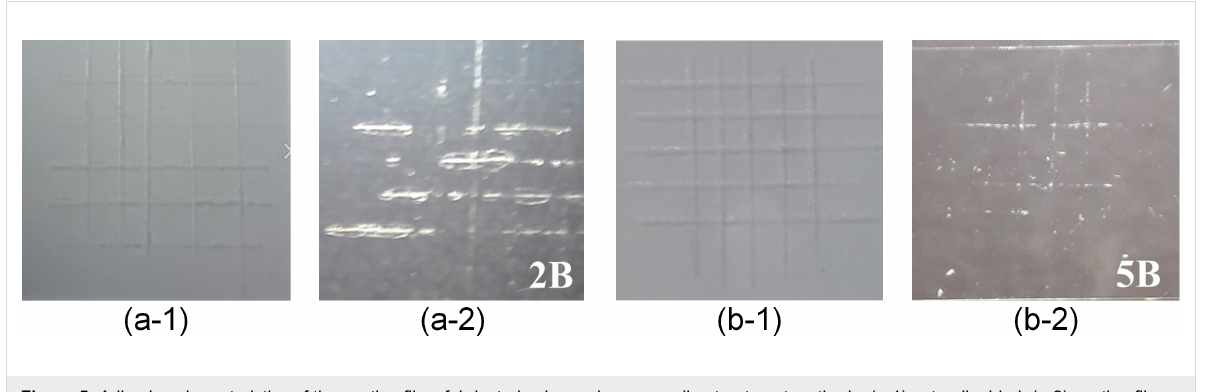
Figure 5: Adhesion characteristics of the coating films fabricated using various annealing treatment methods: (a-1) naturally dried; (a-2) coating film after the adhesion test; (b-1) annealed; and (b-2) coating film after the adhesion test.